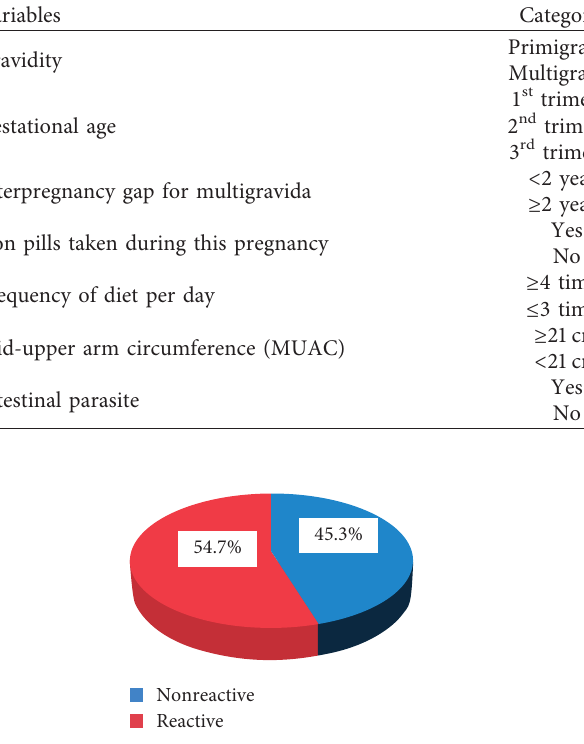
Figure 1: Prevalence of HP infections among pregnant women in Kulito Health Center, SNNPR, Ethiopia, 2018 ( n � 236).